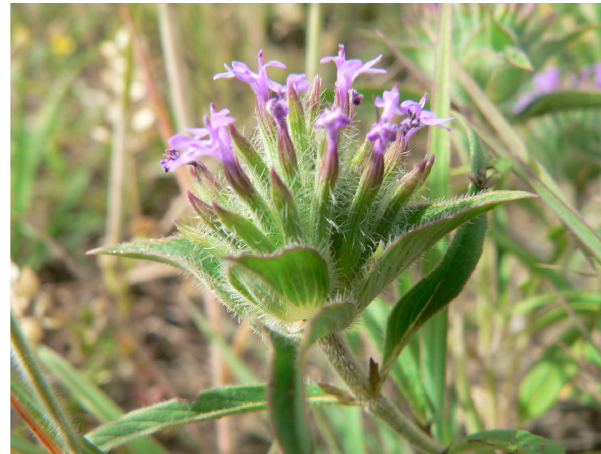
Fig. 2. Ziziphora capitata within the reserve Valea Rea - Radovan